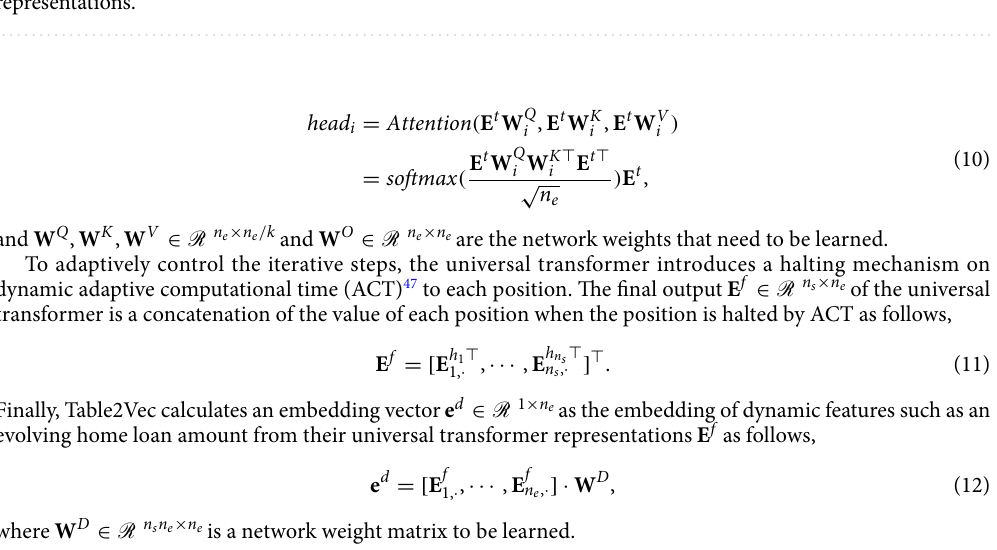
Figure 6. The interpretation module of Table2Vec. The features discriminating a customer’s matter of concerne is traced from the original data, forming the customer’s pattern corresponding to the learned discriminative